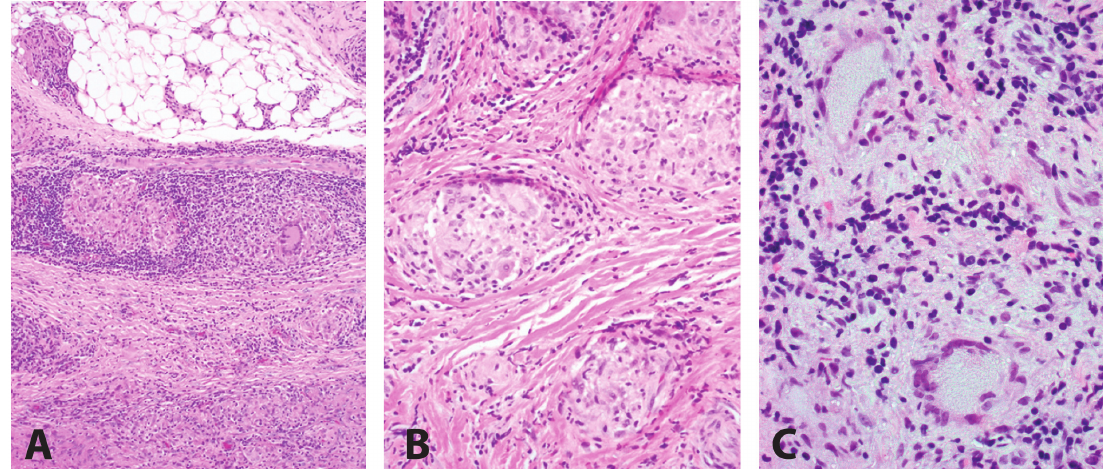
Figure 1. Histopathology with hematoxylin and eosin staining. Light microscopy revealed non-caseating granulomatous inflammation in the orbit ( A, B ) and conjunctiva ( C ). Original magnifications 100x ( A ), 200x ( B ), 400x ( C ). A was from sample 107; B was from sample 101; C was from sample 114. These images were selected for illustrative purposes and the images were all obtained by the diagnostic pathology laboratory at the Johns Hopkins Hospital as part of routine medical care. For histopathological examination, briefly, paraffin sections 5 µm thick were cut and stained with hematoxylin and eosin using standard protocols by the pathology